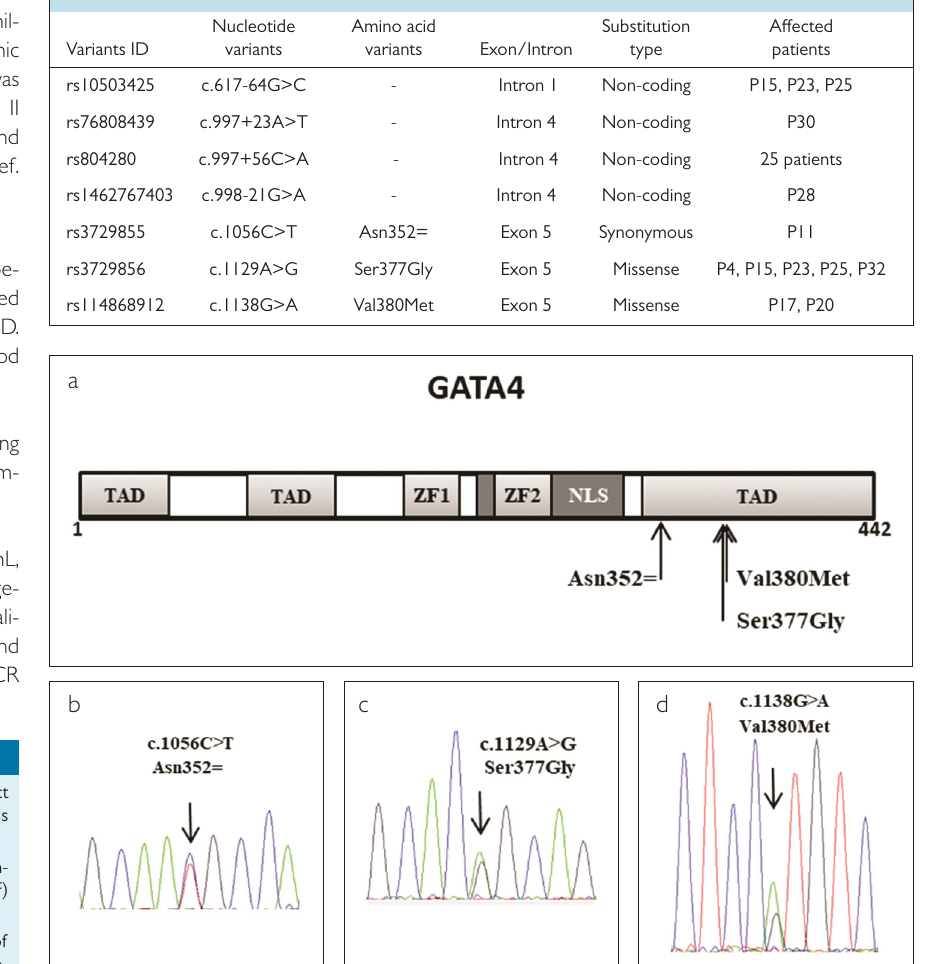
Table 1. Features of GATA4 variants identified in our ASD population